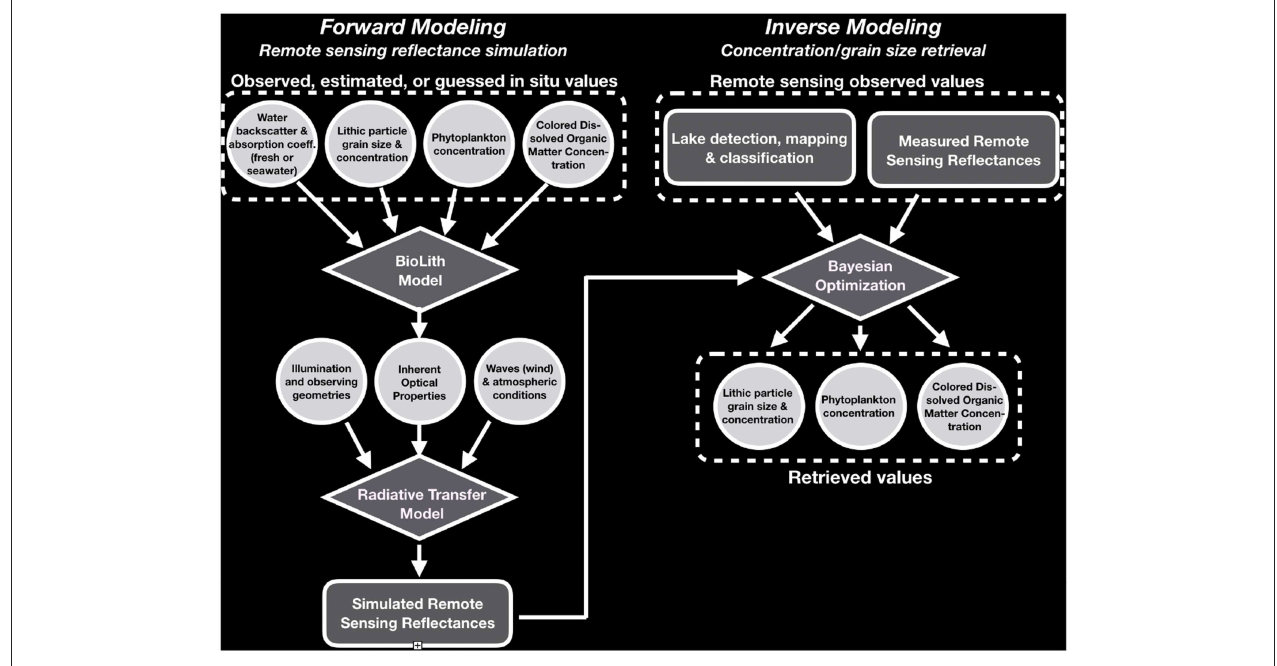
FIGURE 2 | Flowchart of the approach used in the